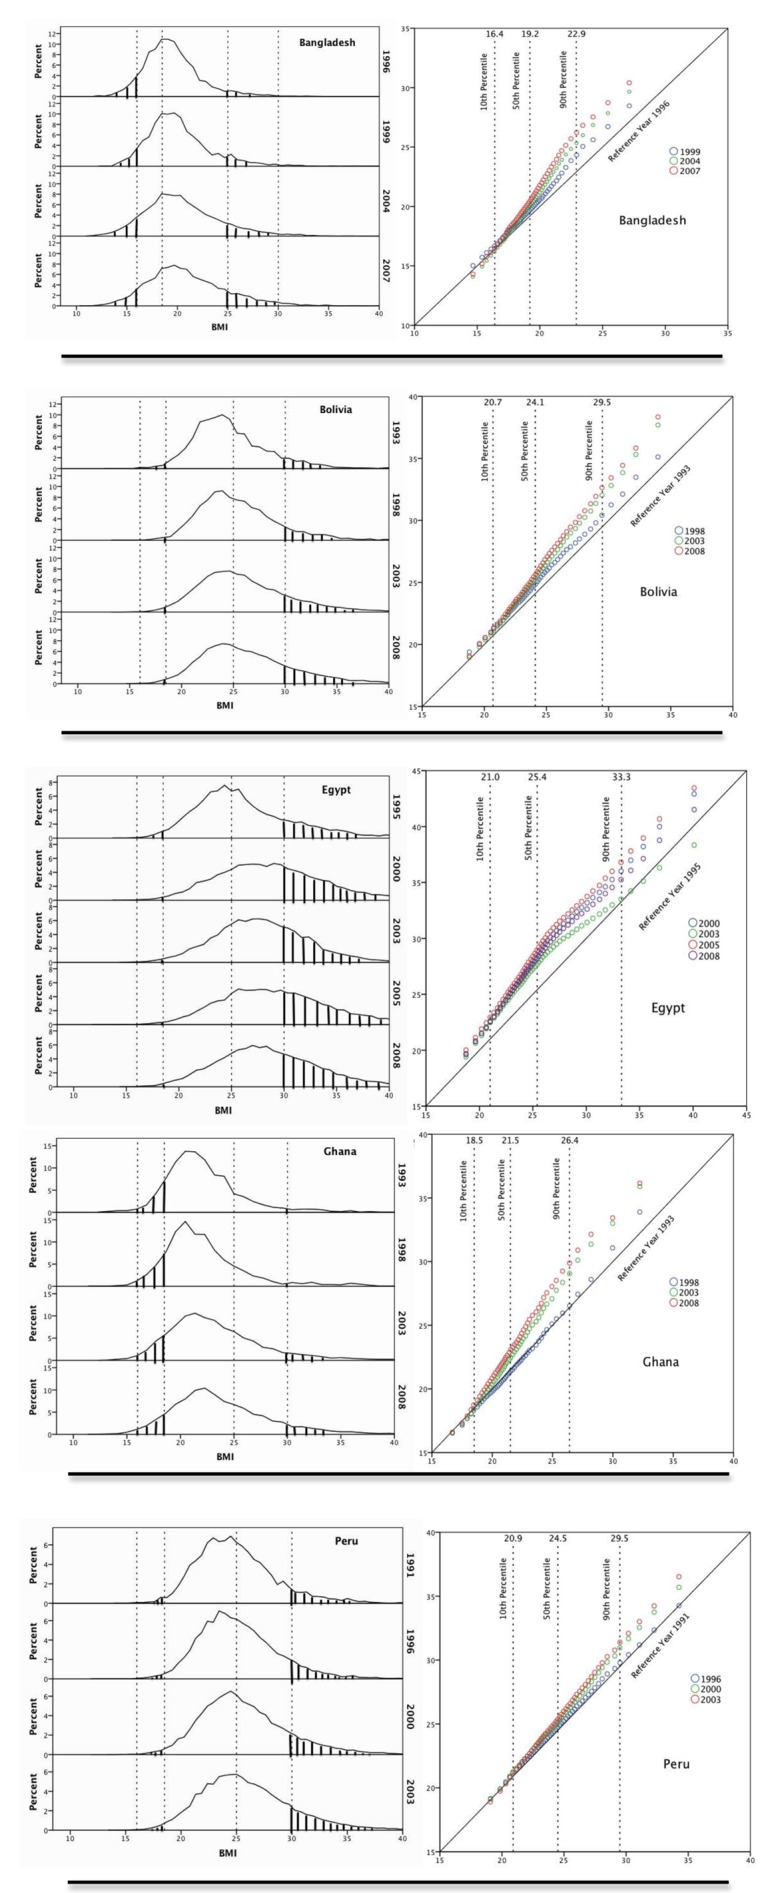
Population distribution of BMI over time in Bangladesh, Bolivia, Ghana, Peru, and Egypt.BMI histograms (panels on left). Vertical reference lines (dotted) represent established thresholds for BMI: 16.0 (chronic energy deficiency), 18.5 (underweight), 25.0 (overweight), and 30.0 (obese). Shaded regions represent proportion with BMI<16.0 or >25.0 in Bangladesh and proportion with BMI <18.5 or >30.0 in Bolivia, Ghana, Peru, and Egypt. QQ plots (panels on right). x-axis BMI at the baseline survey. y-axis BMI at successive survey cycles. The diagonal line y = x is the line of equality between baseline survey and subsequent survey. Vertical reference lines (dotted) represent the 10th, 50th, and 90th percentile, with the value of BMI at the baseline survey at the top of each line.